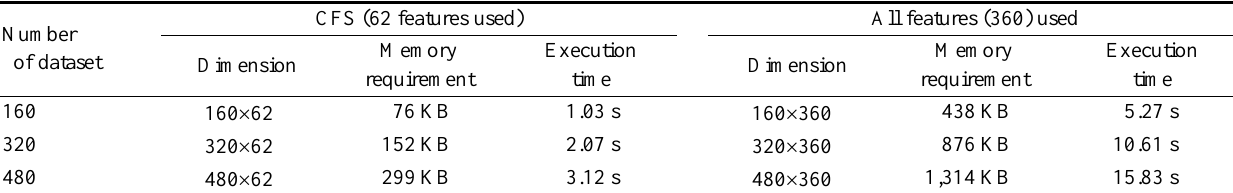
Table 2. Comparison of memory requirement and execution time CFS (62 features used) All features (360) Number of dataset